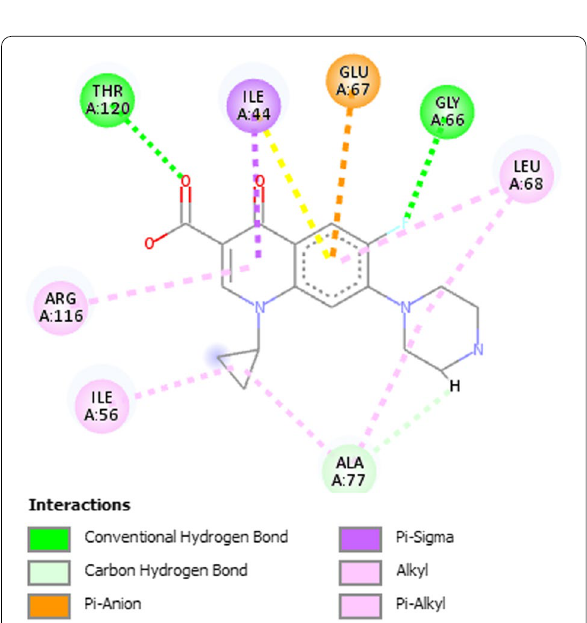
Fig. 15 2D interaction of ciprofloxacin with crystal structure of S